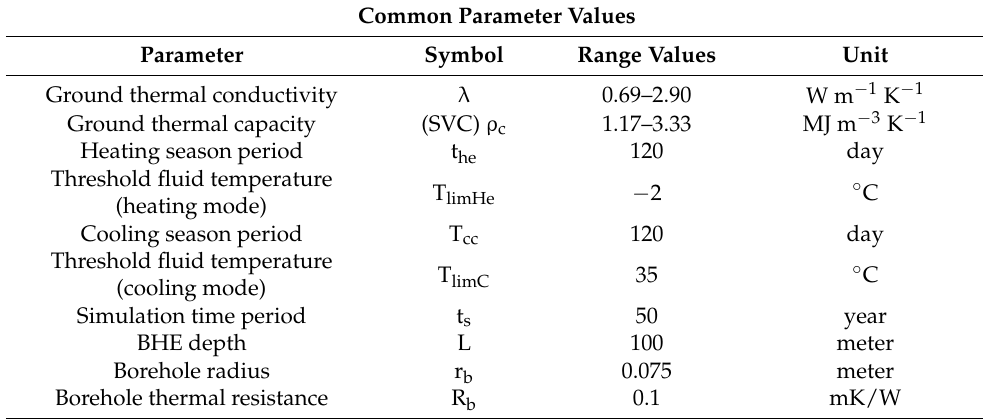
Table 1. Input data for the thermal energy transfers are estimated according to the G.POT method [9].